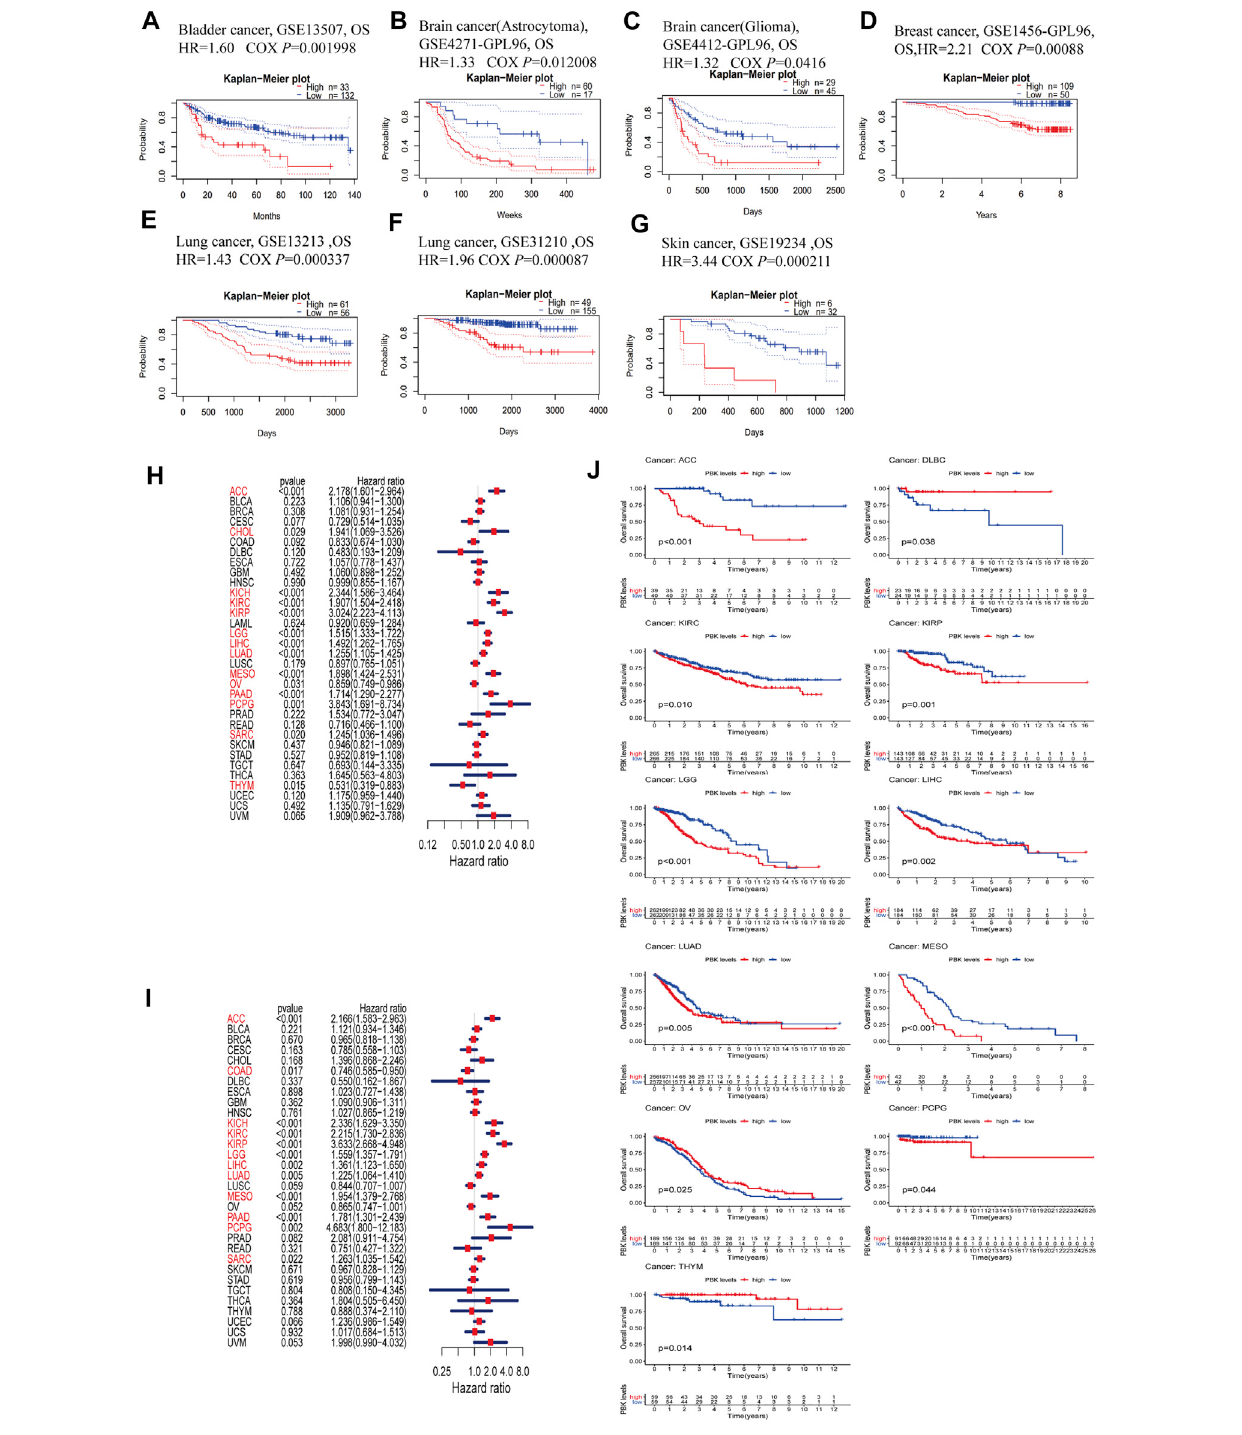
FIGURE 3 | Survival analysis comparing high and low expression of PBK in different types of cancer in the Gene Expression Omnibus and TCGA datasets. (A – G) Kaplan – Meier survival curves in 8 cancer cohorts (GSE13507, GSE4271-GP96, GSE4412-GP96, GSE1456-GP96, GSE13213, GSE31210, and GSE19234). (H, I) Relationship between PBK expression and patient prognosis (OS and DSS) of different cancers in TCGA database. (J) Survival curves of OS in 11 cancer types (ACC, DLBC, KIRC, KIRP, LGG, LIHC, LUAD, MESO, PCPG, OV, and THYM) in TCGA.